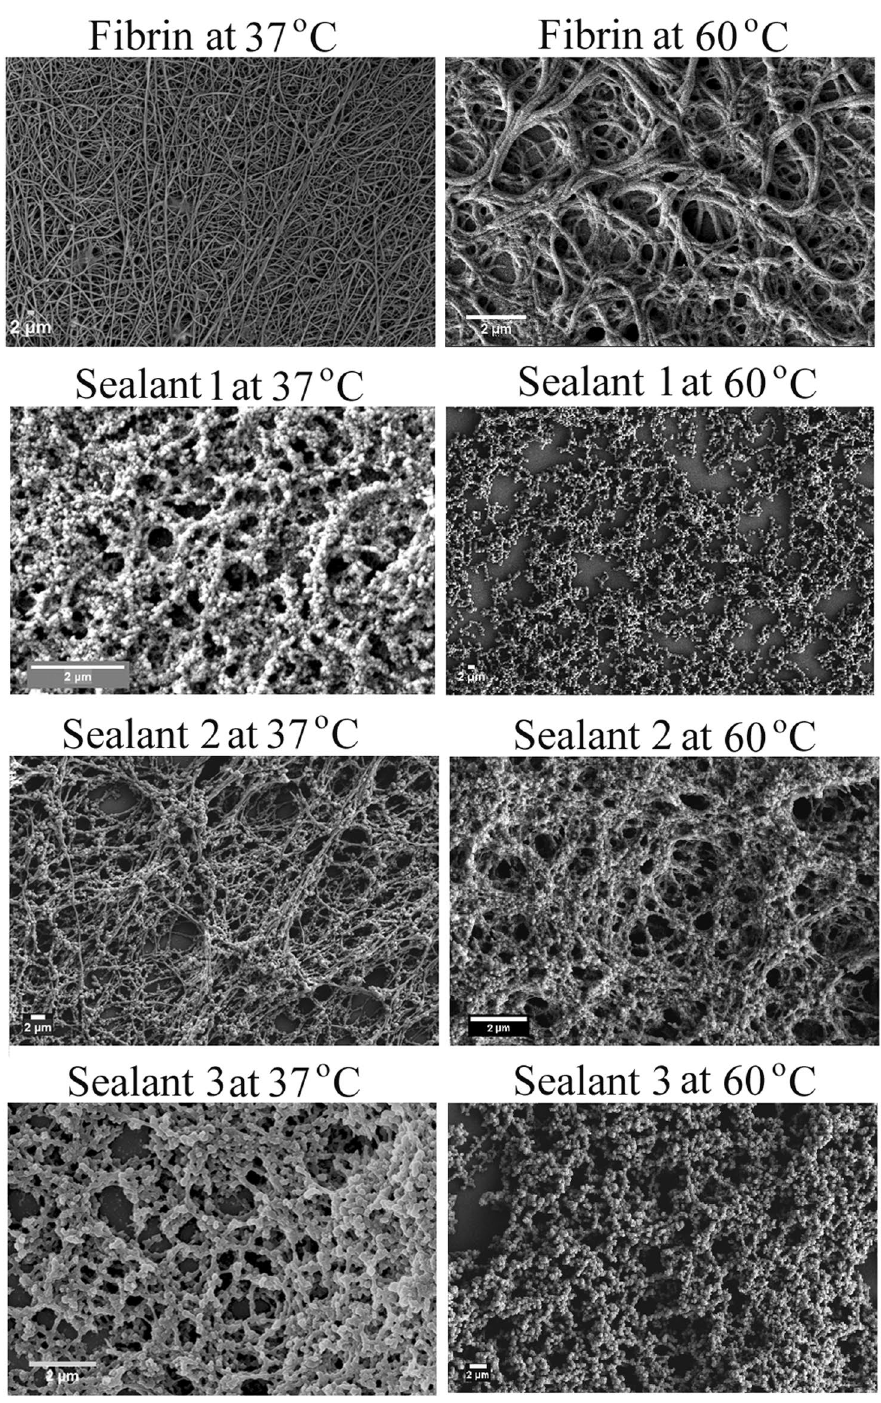
Figure 2. FE-SEM images of fibrin, sealant 1, 2 and 3 at 37 °C (left panel) and at 60 °C (right panel). The resolution of FE-SEM images at 37 °C of fibrin, sealant 1, 2 and 3 are 10.86, 32.7, 4.97 and 23.69 KX respectively. The resolution of FE-SEM images at 60 °C of fibrin, sealant 1, 2 and 3 are 21.06, 2.57, 19.75 and 6.05 KX, respectively. Scale bar of all the SEM images are 2 µ